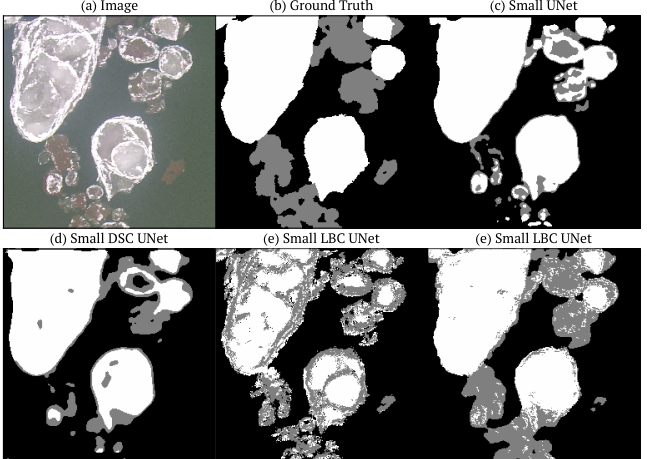
Figure 5. Comparison of predictions after one epoch of training on the suite of Small UNets. The mean IoU for the Small UNet, Small DSC UNet, Small LBC UNet and Small DSC LBC UNet are 65.9, 67.2, 56.7, and 78.7, respectively. The mean pixel accuracy for the Small UNet, Small DSC UNet, Small LBC UNet and Small DSC LBC UNet are 75.0, 76.0, 69.2, and 88.8 respectively. Note that detail can be more easily observed when zoomed